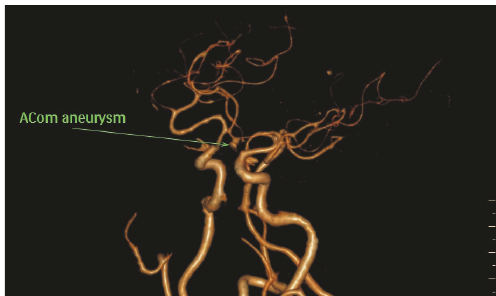
Figure 5: 3D cerebral CTA showing a saccular aneurysm at the ACoA.